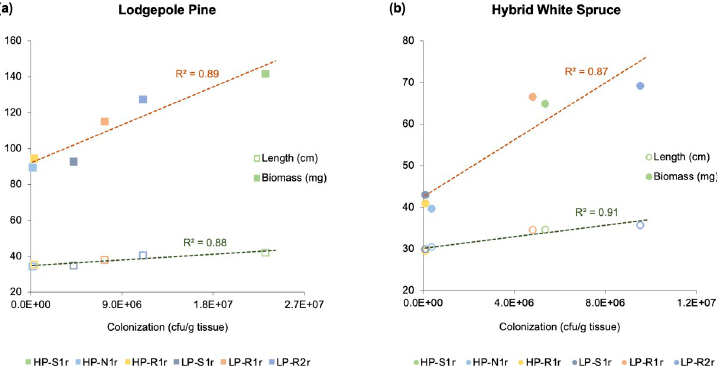
Fig 4. Correlation of bacterial population sizes (x-axis) with length and biomass (y-axis) of (a) lodgepole pine and (b) hybrid white spruce seedlings. For this correlation, the population sizes in the rhizosphere and internal tissues were aggerated for each strain ( Caballeronia sordidicola HP-S1r, Pseudomonas frederiksbergensis HP-N1r, Phyllobacterium myrsinacearum HP-R1r, Pseudomonas mandelii LP-S1r, Paraburkholderia phytofirmans LP-R1r and Caballeronia udeis LP-R2r). Population size, length and biomass variables were analyzed 540 days after the inoculation of pine and spruce.